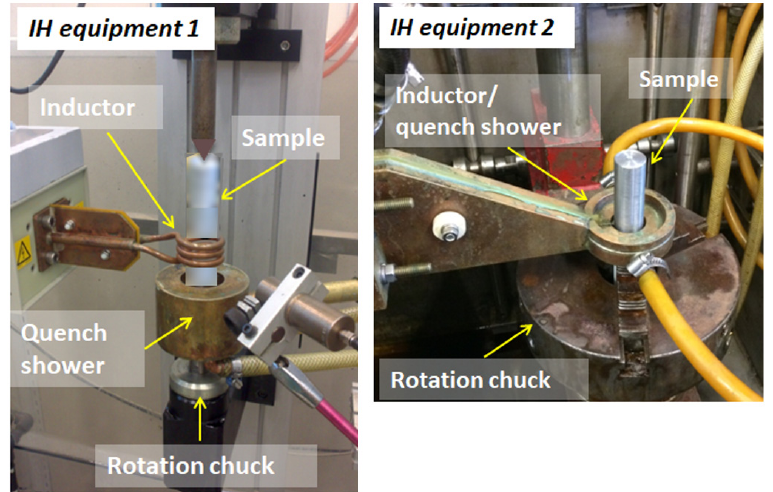
Figure 2. Overview of the induction heat treatment equipment used to harden the samples.